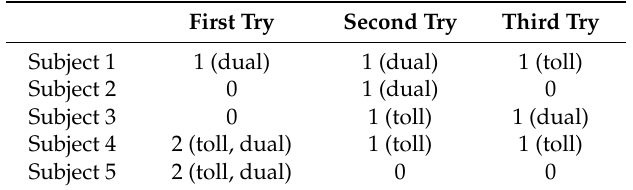
Table 3. Results of the second walking test (failure of obstacle avoidance).